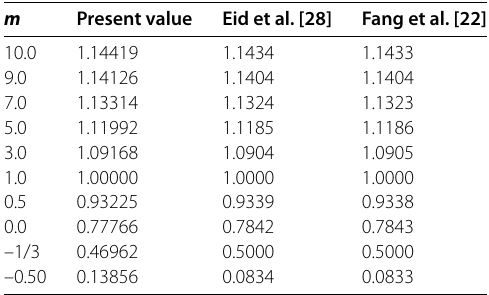
Table 4 Values of – f (cid:2)(cid:2) (0) for different values of m when n = 0.5, We = 0, λ = 0, M = 0, D = 0 and α = 0.25